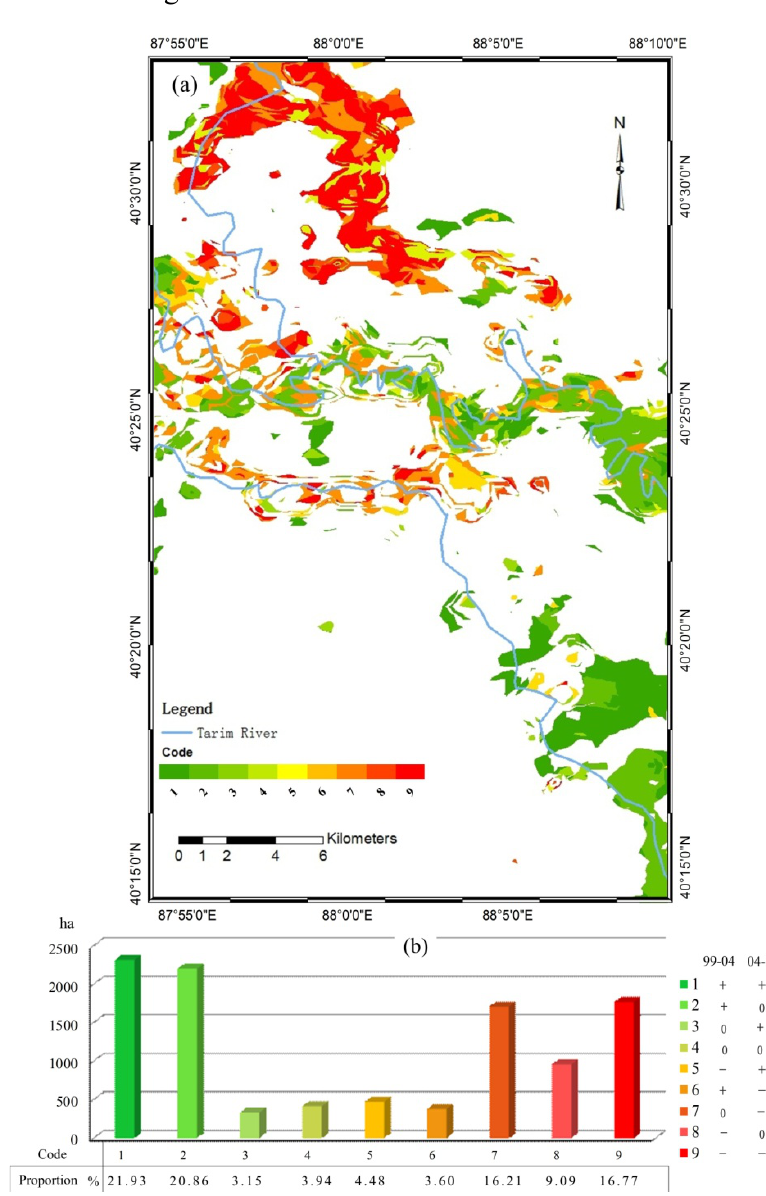
Figure 6. ( a ) Change trajectory for Populus euphratica forests from 1999 to 2009; ( b ) statistical data for change area and for various